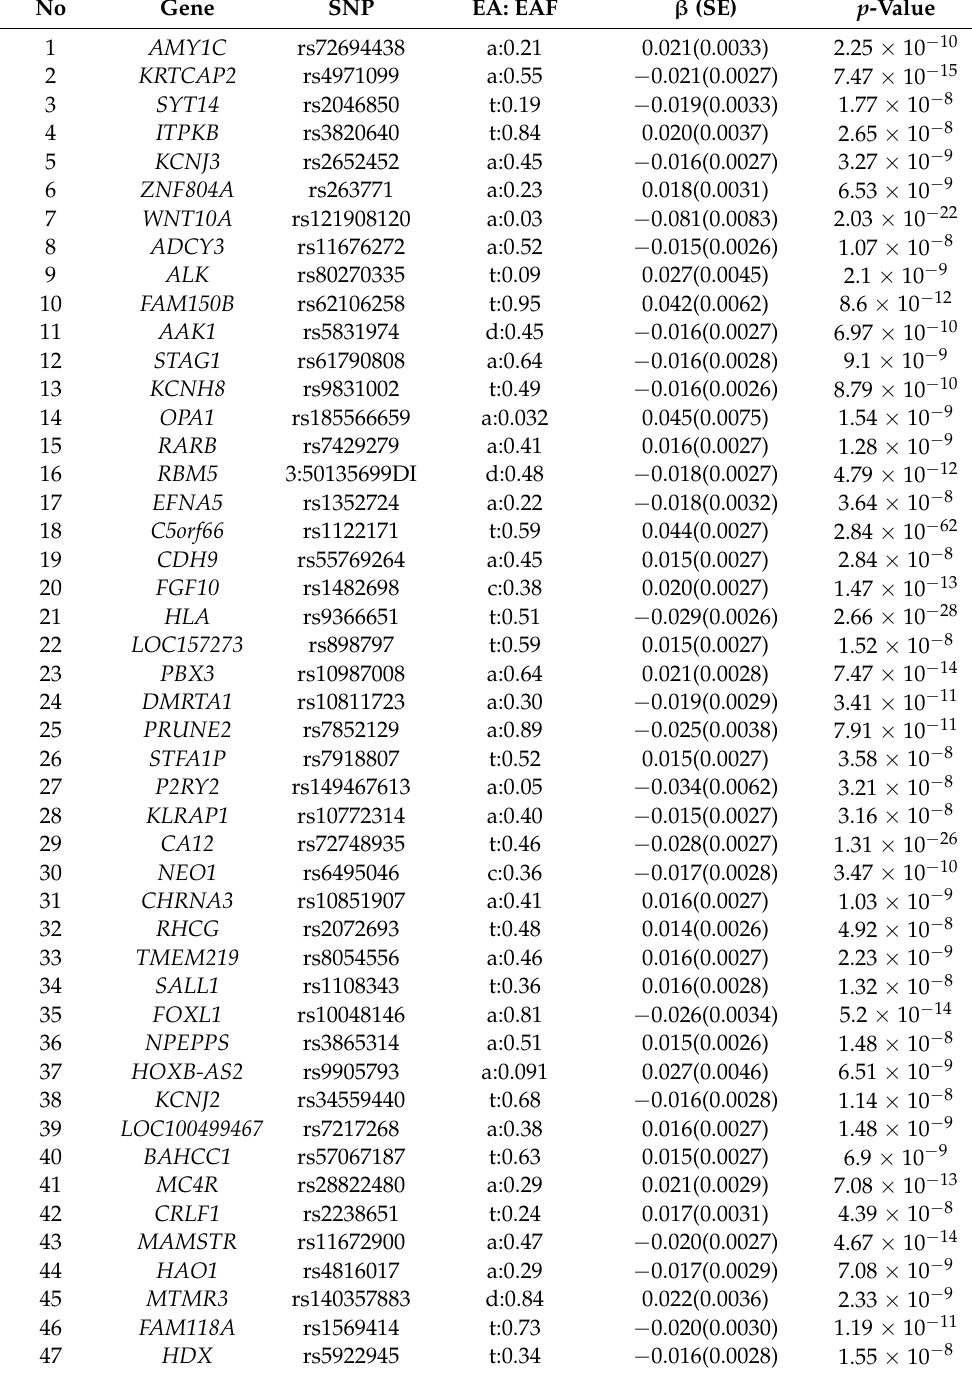
Table 1. Forty-seven independent SNPs associated with dental caries and